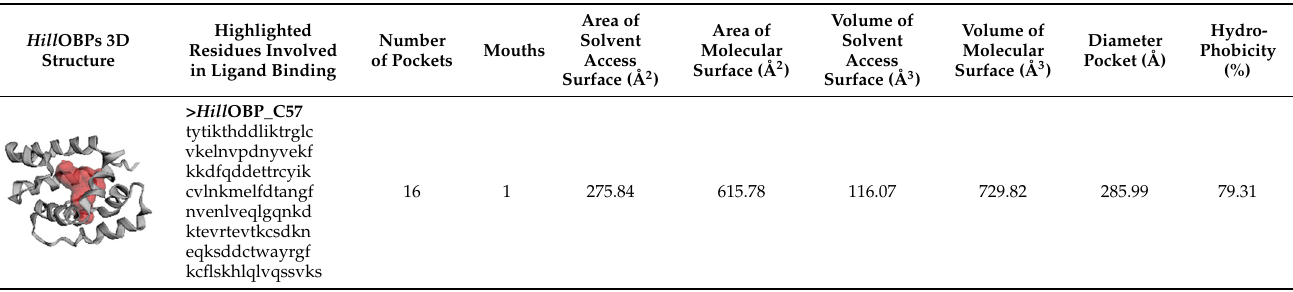
high percentage of hydrophobicity for HillOBP_C57 and HillOBP_C21691 binding pockets.